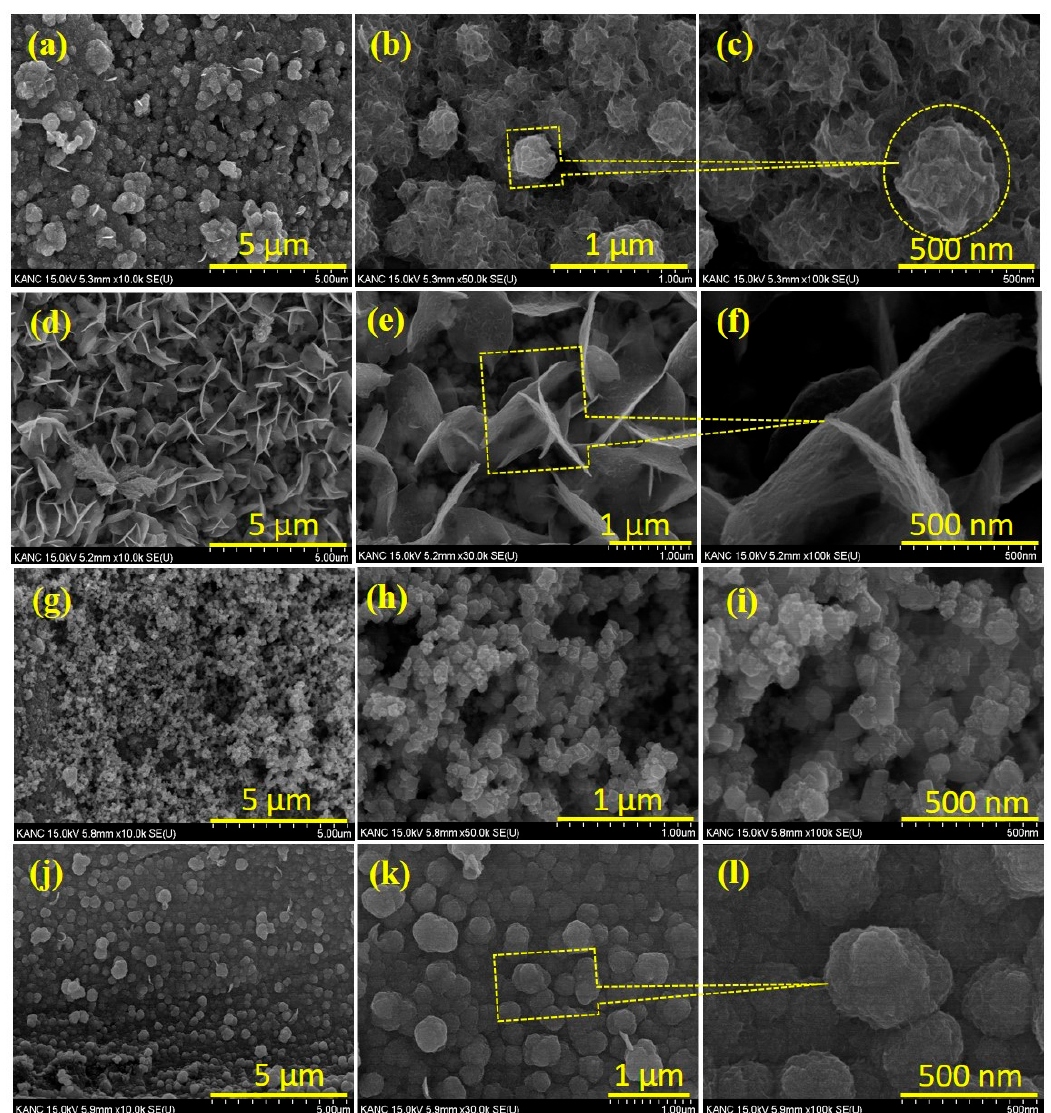
Figure 2. FE-SEM images of Samples ( a – c ) S-1, ( d – f ) S-2, ( g – i ) S-3, and ( j – l ) S-4.